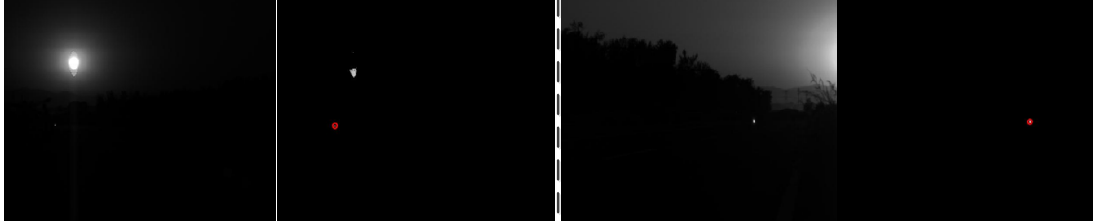
Figure 8. The detection results under sunlight.